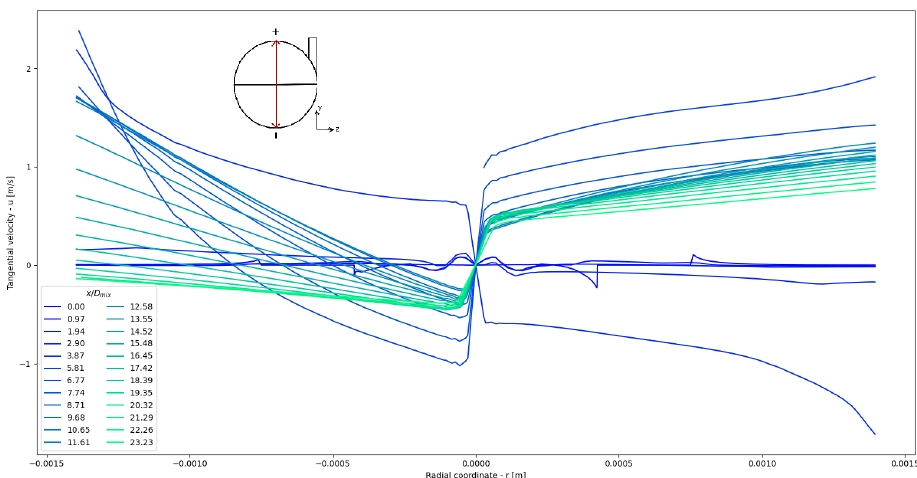
Figure 18. Tangential velocity plot in the y direction. Positive r direction is in the direction furthest offset from the flow path of the bypass inlet, θ bp = 270 ◦